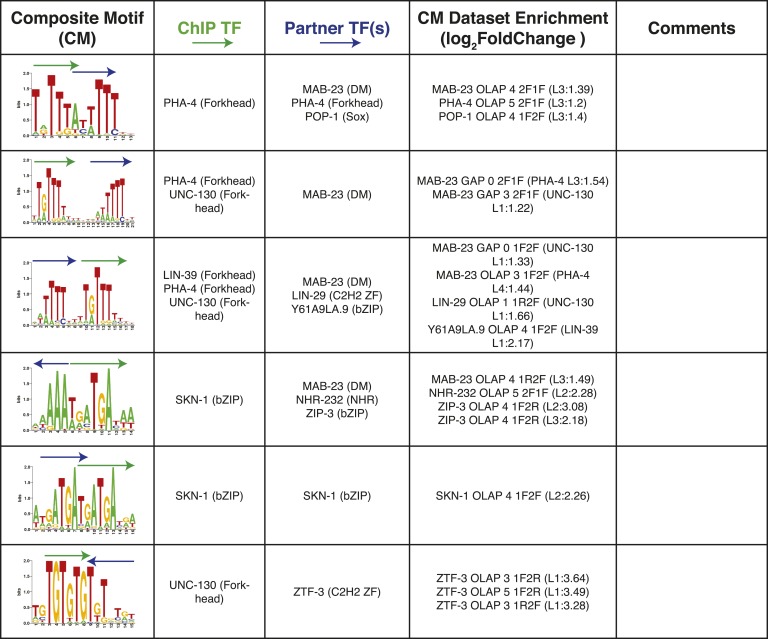
Summary of clustered CMs enriched in C. elegans ChIP-seq peaks (continued).CM-cluster centroids are shown for the enriched motifs. For each cluster, the ChIPed TF(s) and potential partner TF(s) are listed along with information about motif overlap (OLAP), spacing (GAP), and enrichment. Colored arrows over motif indicate high-information content portions of either factor.